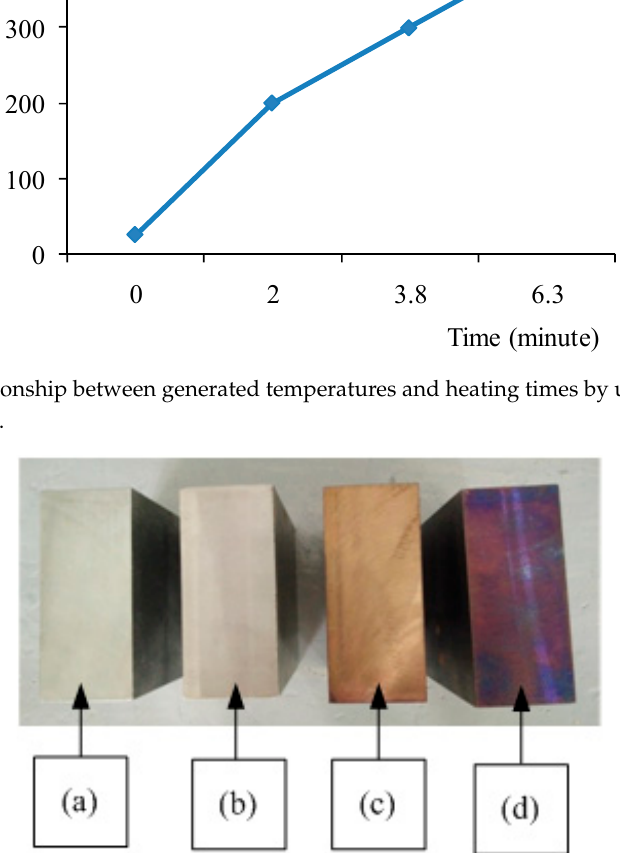
Figure 4. The initial workpiece ( a ) and preheating workpieces of 200 °C ( b ), 300 °C ( c ), and 400 °C ( d ).